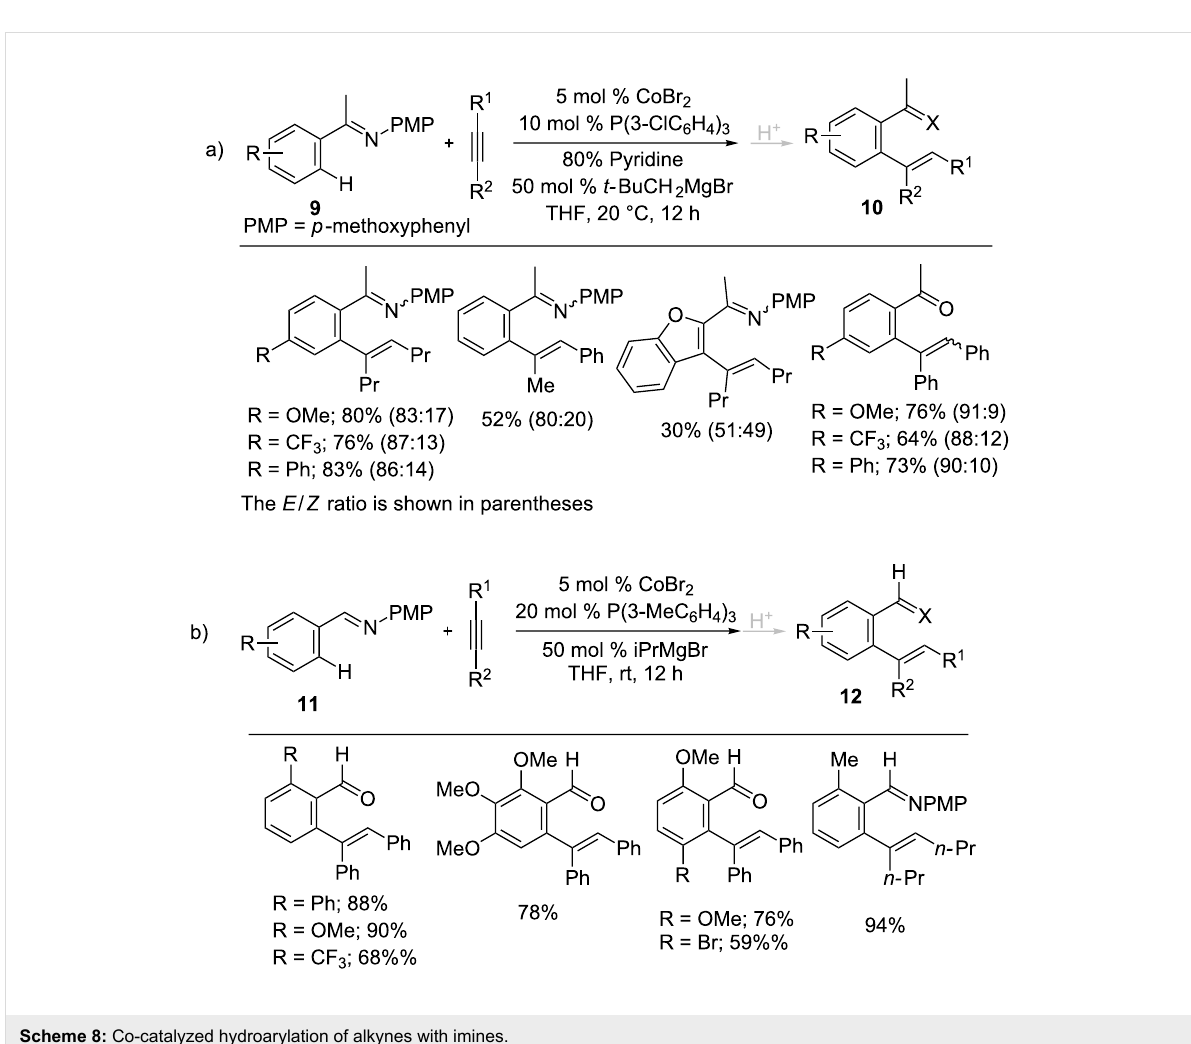
Scheme 8: Co-catalyzed hydroarylation of alkynes with imines.